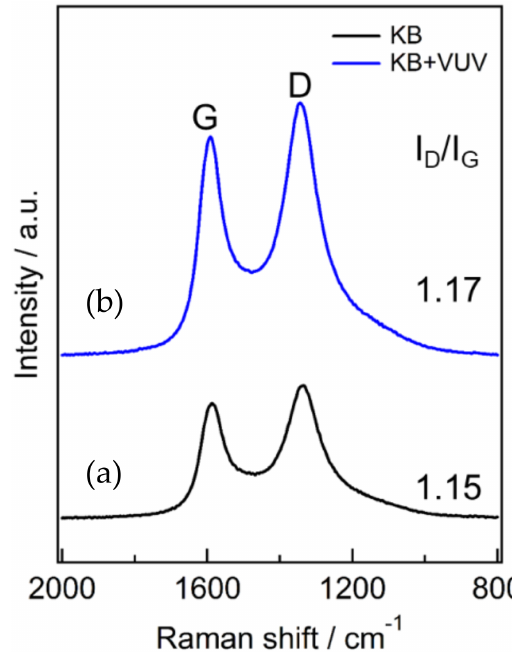
Figure 4. Raman spectra of (a) KB and (b) KB +